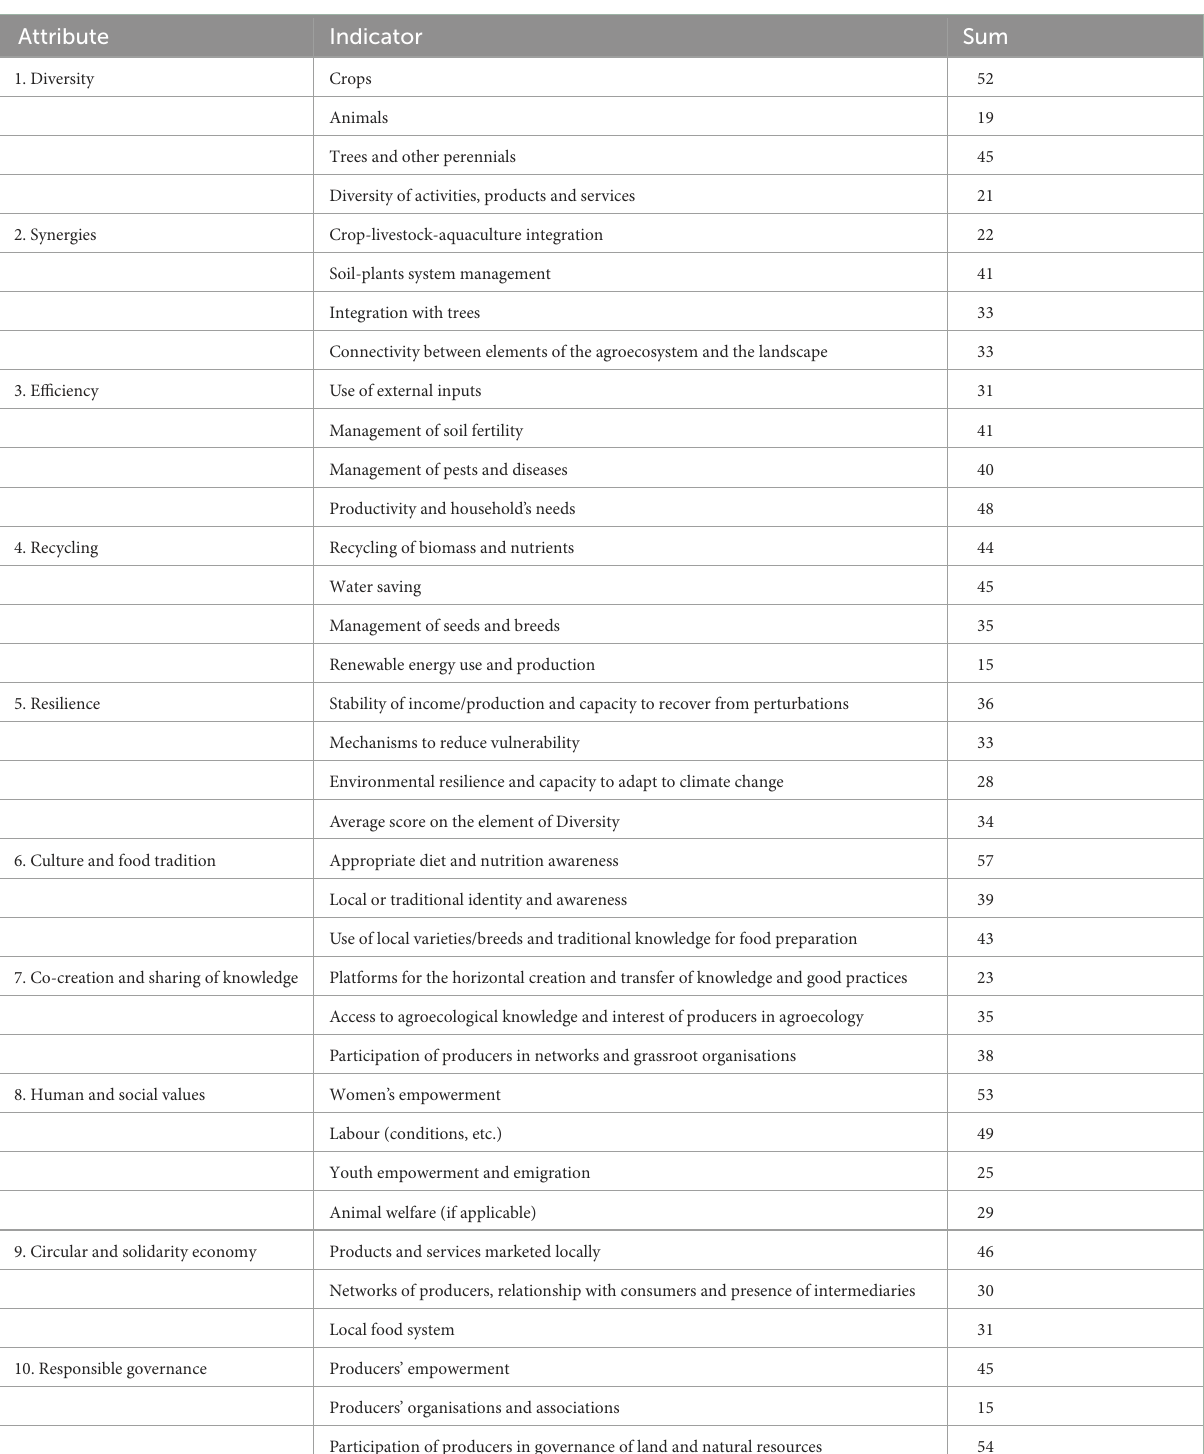
TABLE 4 Cumulative score of the 16 assessed farms on the 36 TAPE indices (max score = 64).